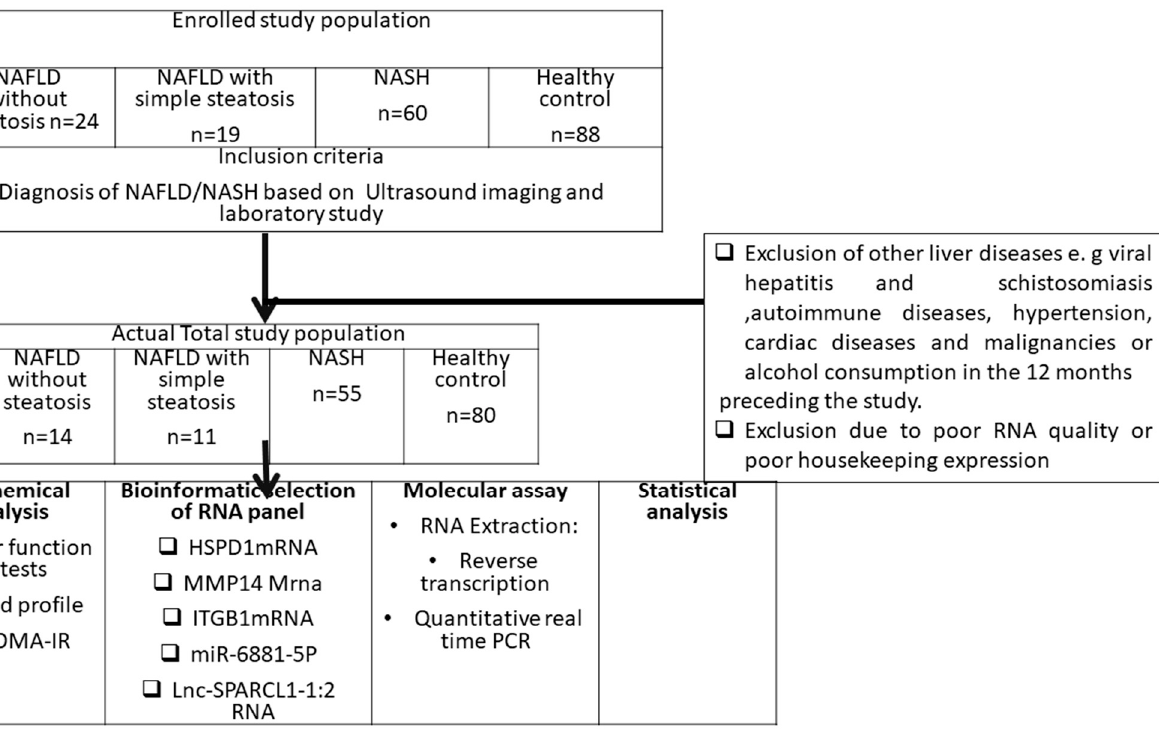
Figure 1. Flowchart of the study design.